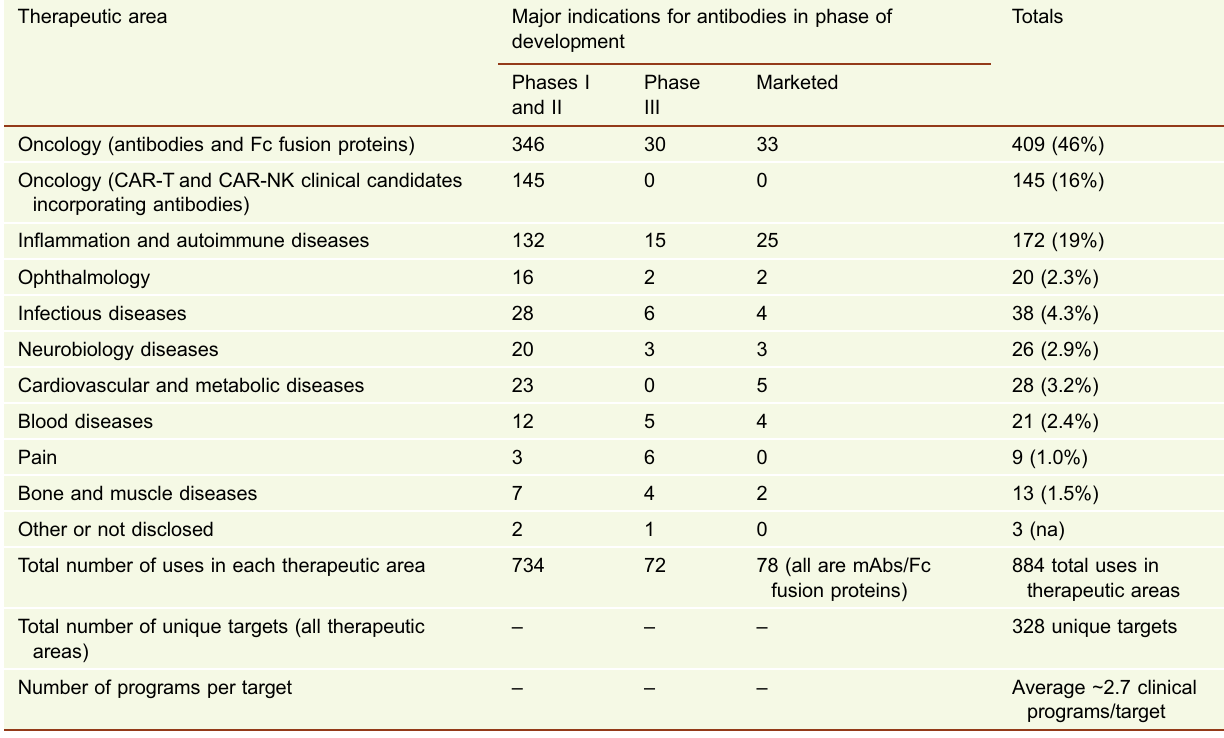
Table 4. Therapeutic areas targeted by innovative antibodies, Fc fusion proteins, and CARs in clinical